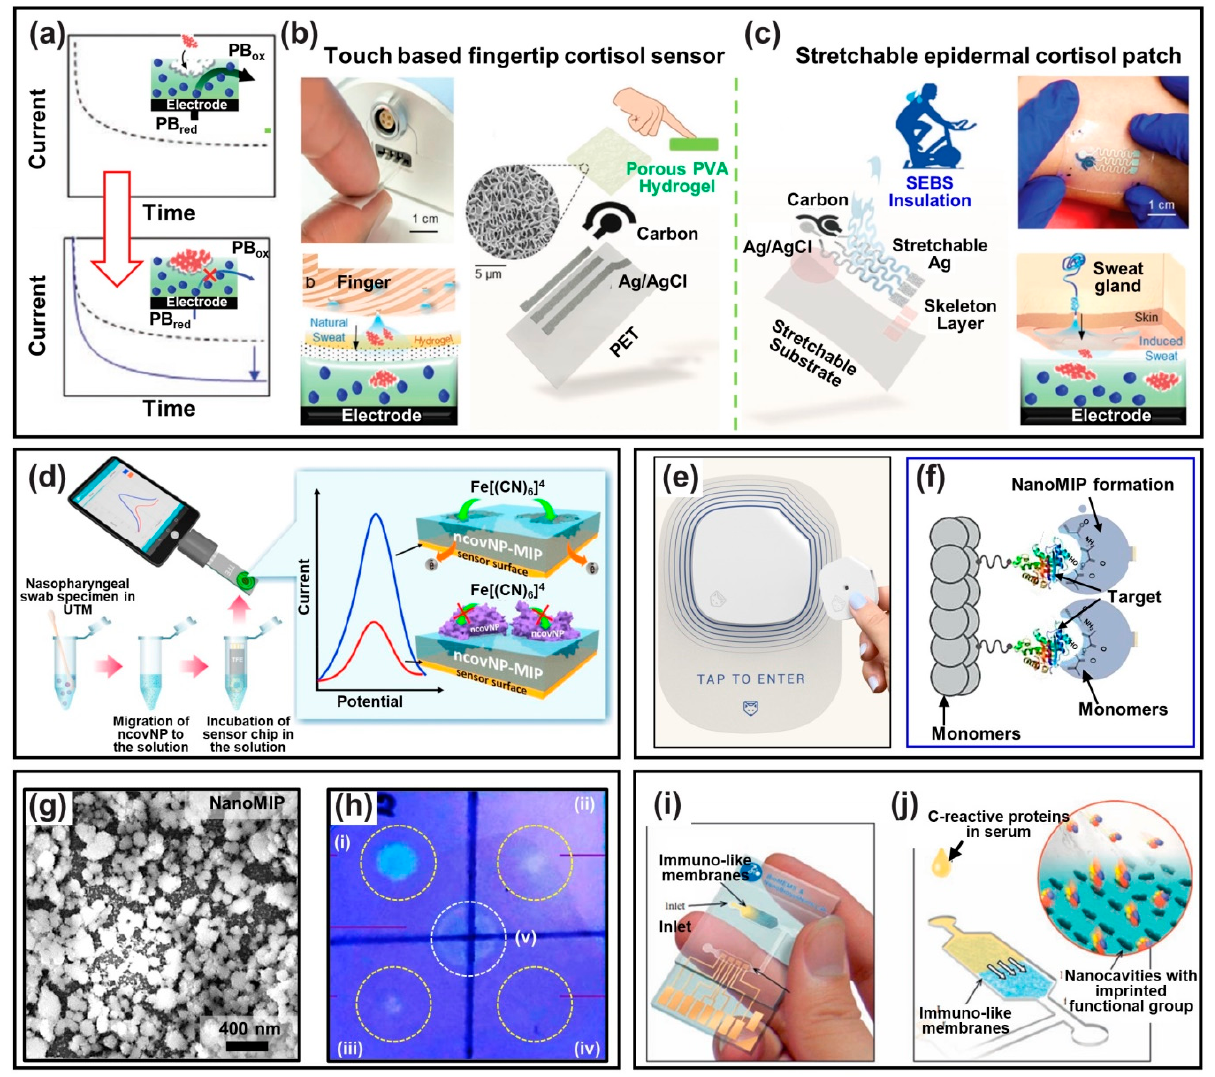
Figure 6. Disposable POC diagnostic biosensors. ( a ) The stress-free sensing platform to detect endogenous cortisol levels from the sweat sampling in an electrode structure with a porous MIP membrane; the reduced current can be measured by oxidation of the imprinted PB by cortisol rebinding process. Reproduced with permission from [133]. Copyright Wiley–VCH, 2021. ( b ) Schematic diagram of MIP-based cortisol sensor based on ‘touch/incubate/detect’ protocol. Reproduced with permission from [133]. Copyright Wiley–VCH, 2021. ( c ) A demonstration of the MIP-based biosensor for a conformal epidermal-integrated patch that tracks changes in cortisol levels during on-body exercise. Reproduced with permission from [133]. Copyright Wiley–VCH, 2021. ( d ) A mobile COVID-19 diagnostic system equipped with a disposable MIP-based biosensor. Reproduced with permission from [106]. Copyright Elsevier, 2021. ( e , f ) An image and concept of commercialized COVID-19 image of the nanoMIP film surface. ( h ) Optical micrographs captured from the dot blot assay for SARS-CoV-2 detection; (i) SARS-CoV-2 full-length spike protein trimer (positive control), (ii,iii) test position (2 × 10 4 PFU), (vi) viral culture media only (negative control), (v) CPN 510B (reference signal). ( i , j ) Scheme of the MIP-based POCT device based on immuno-polymeric membranes with a confined fluidic flow and defined electrode array to isolate CRPs in human serum samples. Reproduced with permission from [128]. Copyright Elsevier,